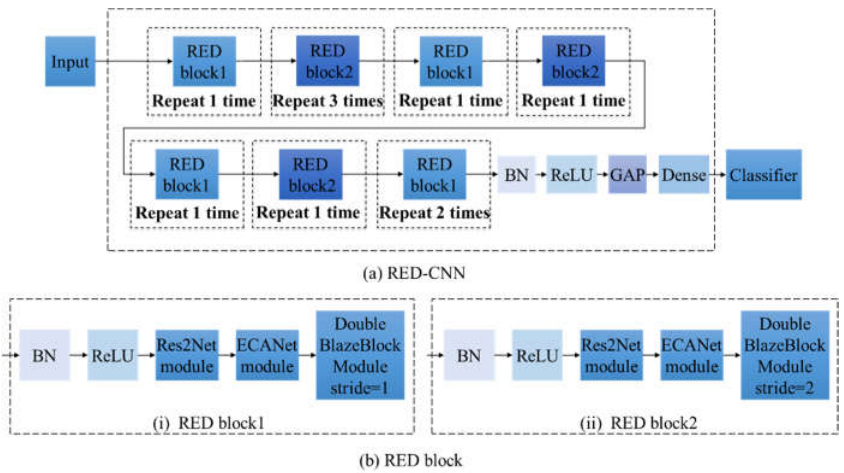
Figure 3. Sample distribution of class data.